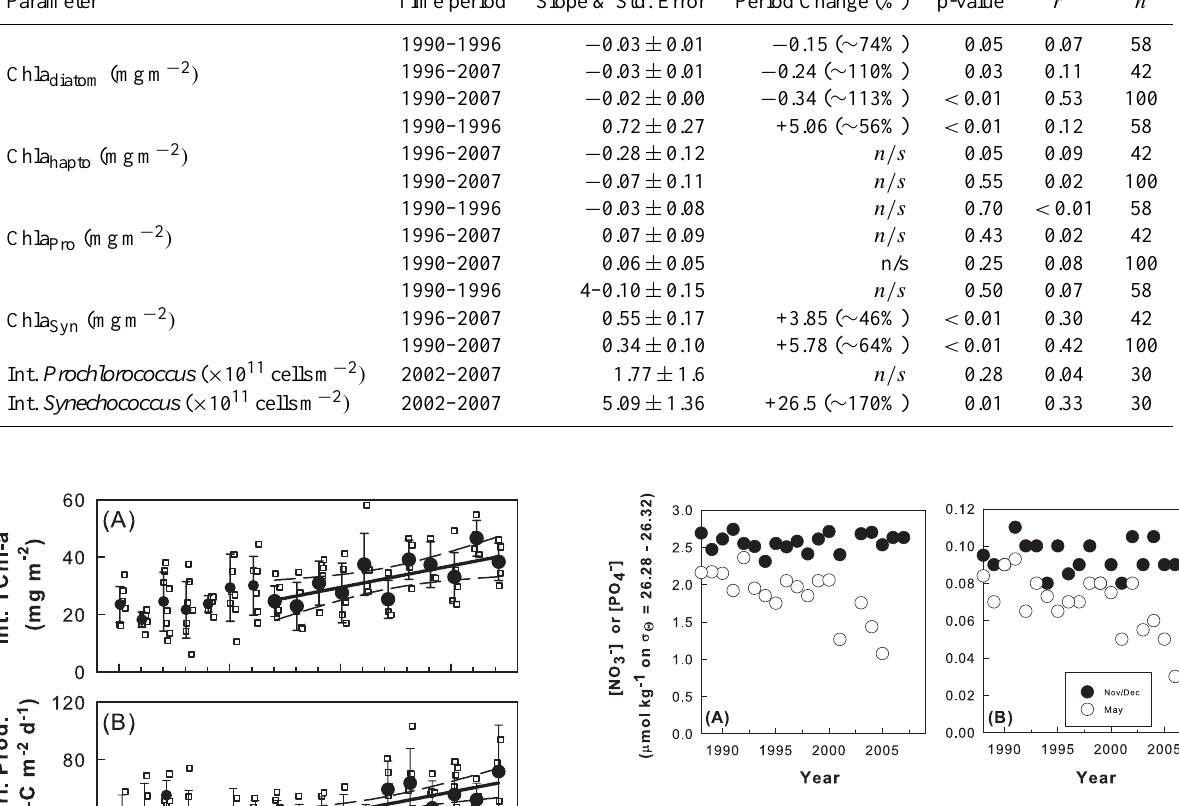
] and (b) [PO − 3 ] con- 3 4